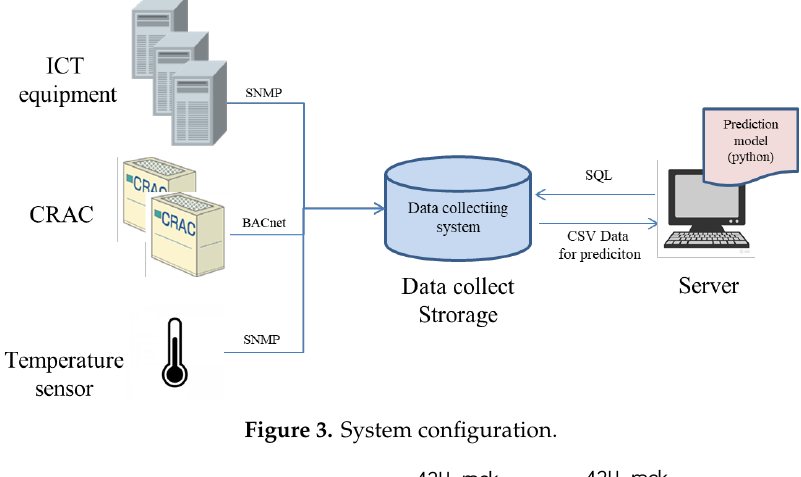
Figure 3. System configuration.